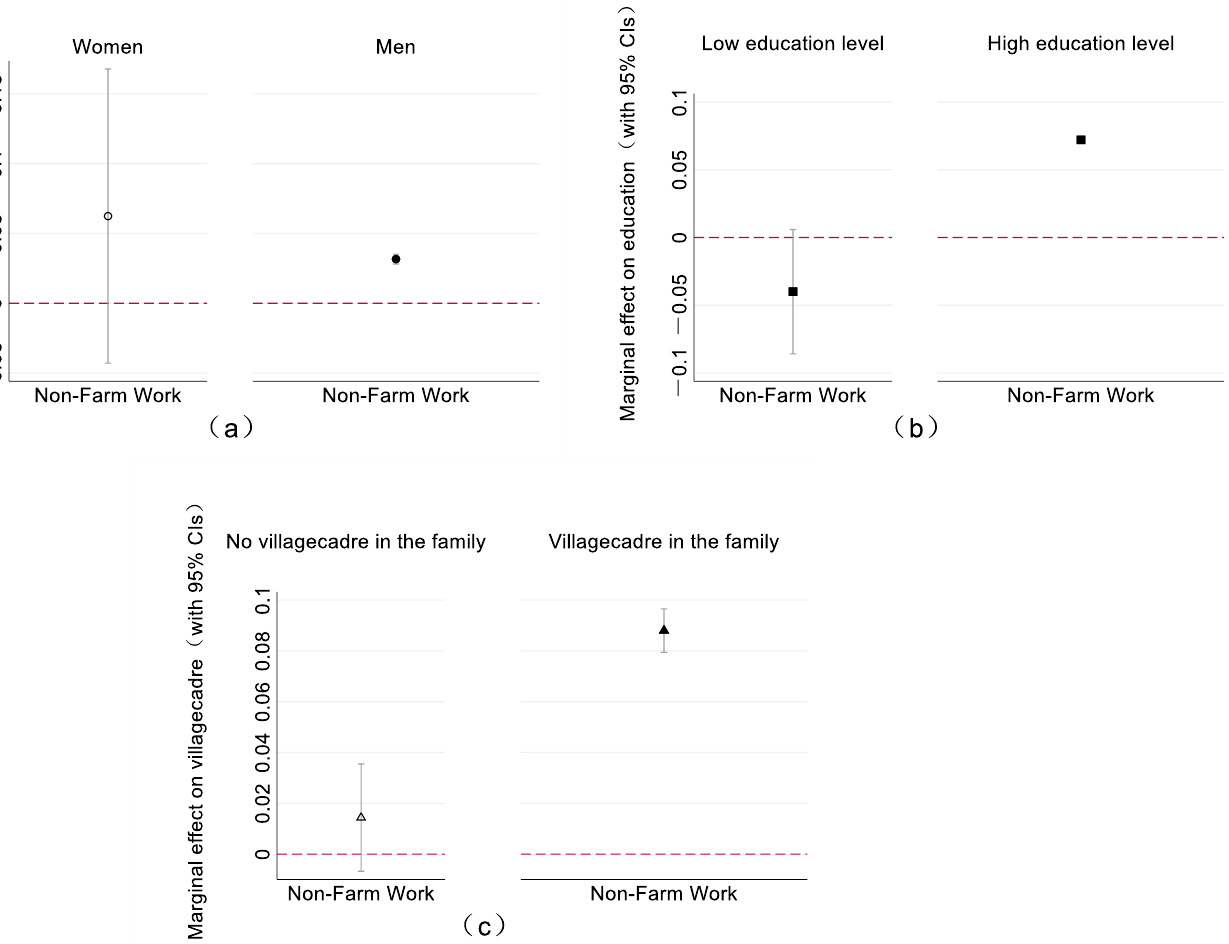
Table 7. Marginal Effects of Women’s Non -Farm Income.